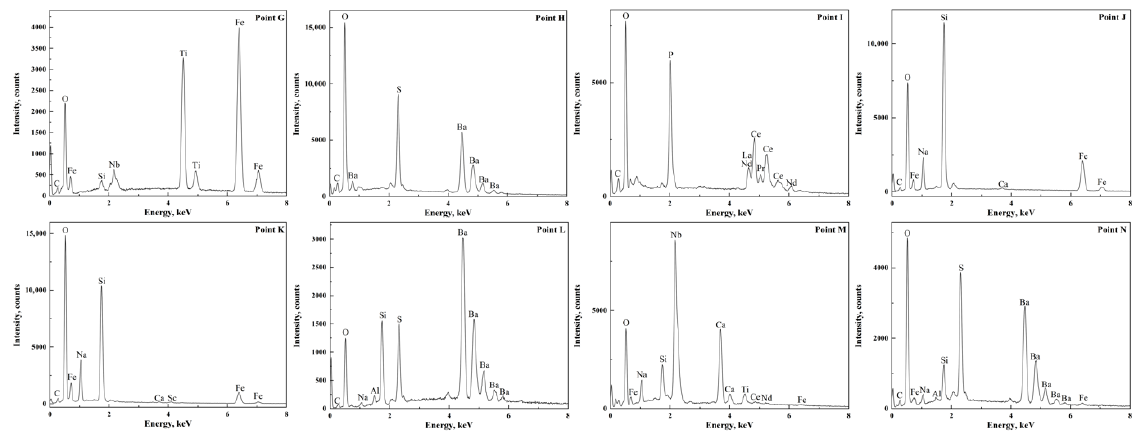
Figure 10. EDS analysis results of points in Figure 9. Table 3. EDS analysis results of points in Figure 9